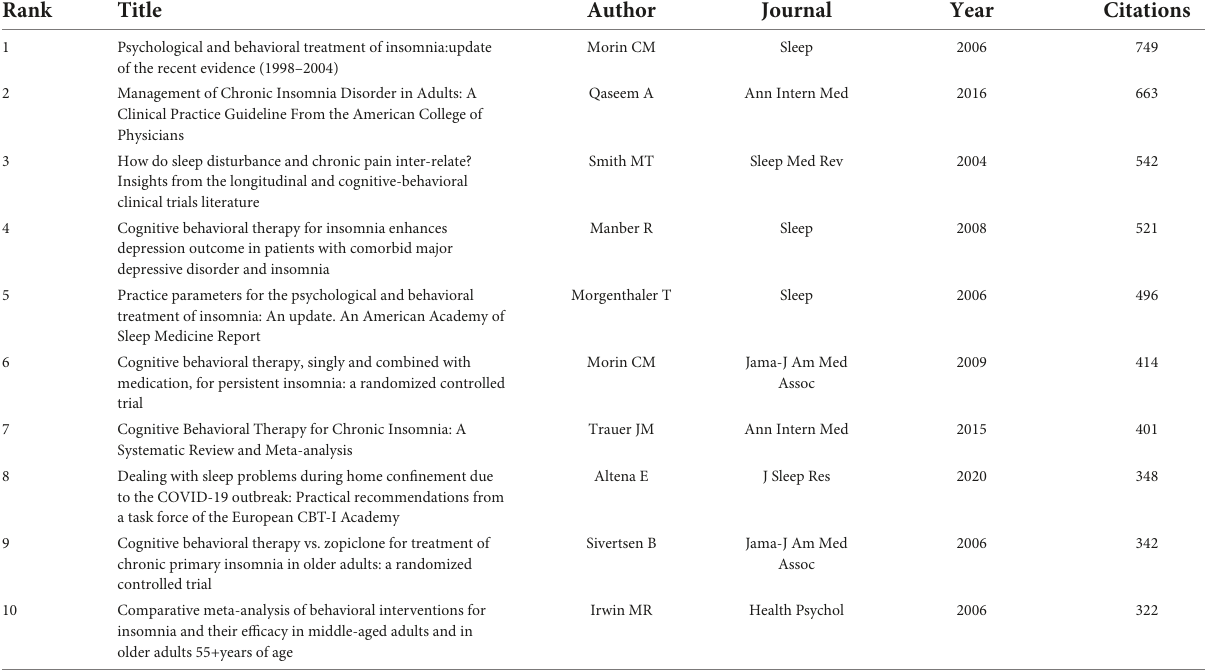
TABLE 4 Top 10 most cited papers on CBTI during study